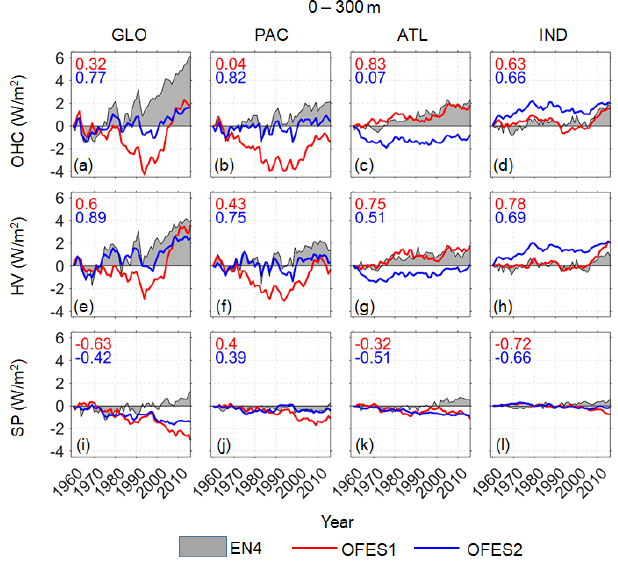
Figure 2. Time series of the global and basin-wide OHC (top), HV (middle), and SP (bottom) between 0–300m based on the three datasets. The OHC, HV, and SP here are converted to the accumu- lative heating in Wm − 2 applied over the entire surface of Earth. Gray shadow: EN4; solid red line: OFES1; solid blue line: OFES2. Numbers on the top left corners are the correlation coefficients be- tween OFES1 (red) or OFES2 (blue) and EN4. The OHC hereafter is directly calculated from the potential temperature, rather than the sum of the HV and